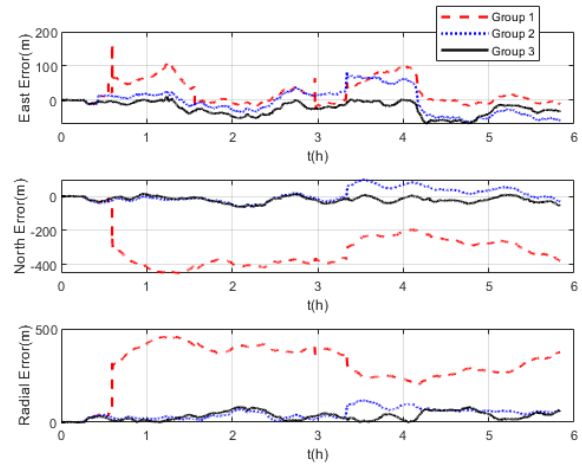
Figure 9. Comparison of positioning errors at mid − latitudes.